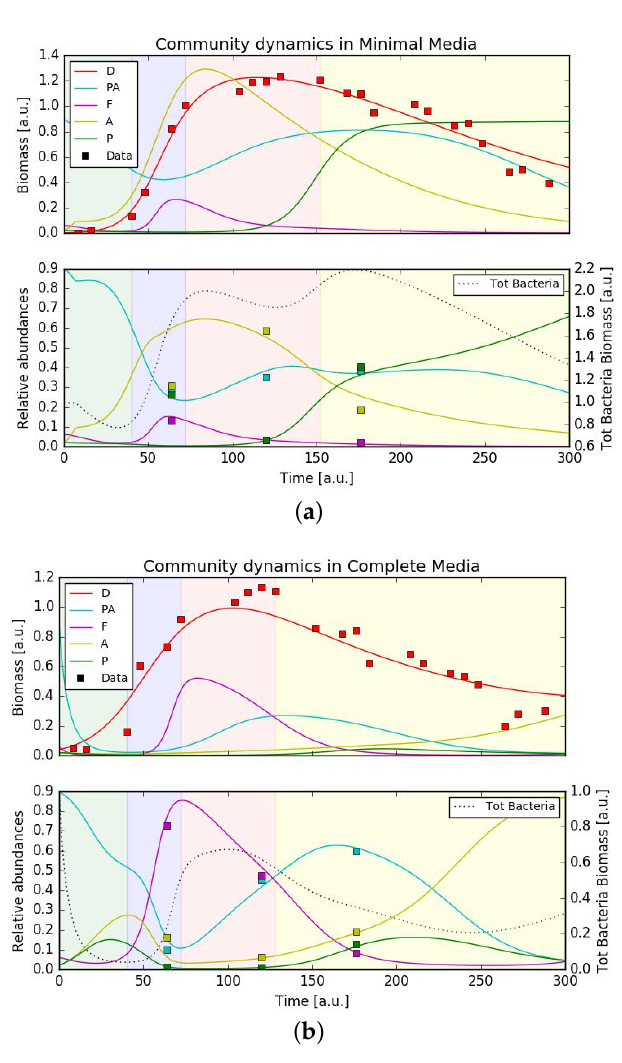
Figure 4. Simulation results (lines) and experimental data (squares) for communities of P. tricornutum ( D ), Pseudoalteromonadaceae ( PA ), Flavobacteriaceae ( F ), Alteromonadaceae ( A ) and Pseudomonadaceae ( P ) in ( a ) minimal media and ( b ) complete media conditions. The top panel shows the biomass time course (arbitrary units) for the five organisms and the rescaled data points (squares) for the P. tricornutum . The bottom panel shows the variations in relative abundances of the four bacteria (single bacteria biomass/total bacteria biomass) over time and the three sets of data points from the sequencing analysis (the first data point is used as starting condition at time 0). Also shown in the bottom plot (dotted line, right y -axis) is the total bacterial biomass in arbitrary